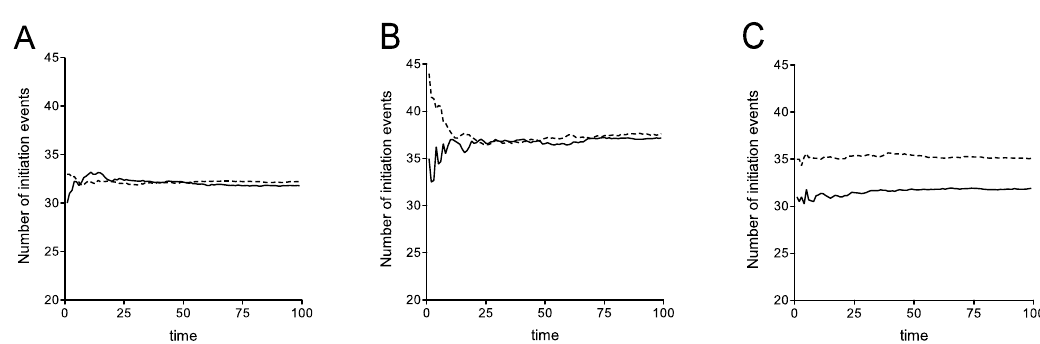
Figure 7. Stochastic simulations of a downstream scanning model of translation. Stochastic simulations of a downstream scanning model of translation that simulates resumed scanning after C22 termination. This figure explores the effect of rescan (solid line) at the earliest stop codon, contrasted with the case of no rescan (dotted line), using stochastic simulations. In all cases shown a queuing regime is simulated. ( A ) Queuing regime with no recycle; ( B ) Queueing regime with high readthrough; ( C ) Queueing regime: Rescan directly borrows from recycle.